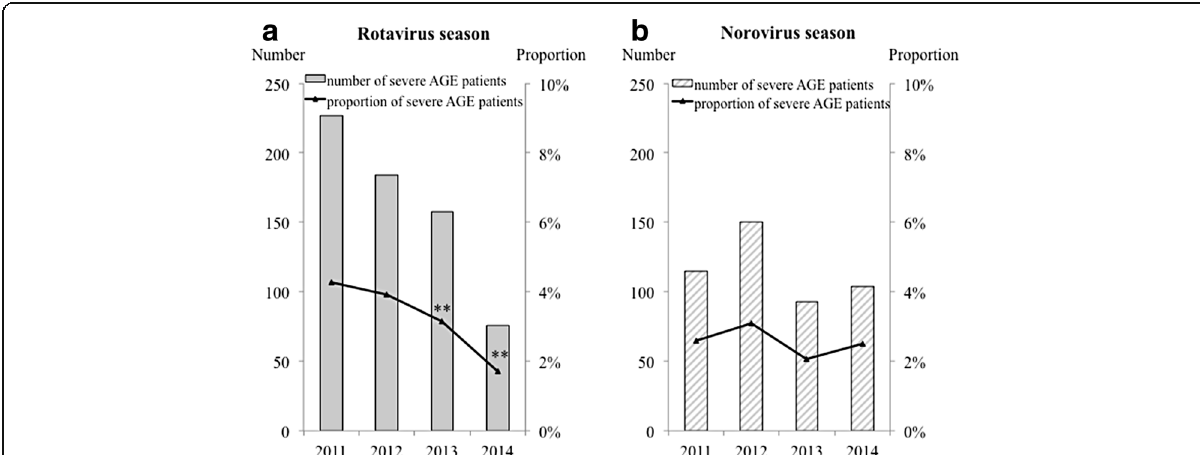
Fig. 4 Numbers and proportions of severe AGE patients ≤ 2 years of age in the a rotavirus and b norovirus epidemic seasons. Gray columns and gray stripe columns indicate number of severe AGE patients ≤ 2 years of age in the rotavirus season and norovirus season each year, respectively. The line indicates the proportions of severe AGE patients based on the total number of visiting patients. ** p < 0.01 compared with in 2011. AGE, acute gastroenteritis